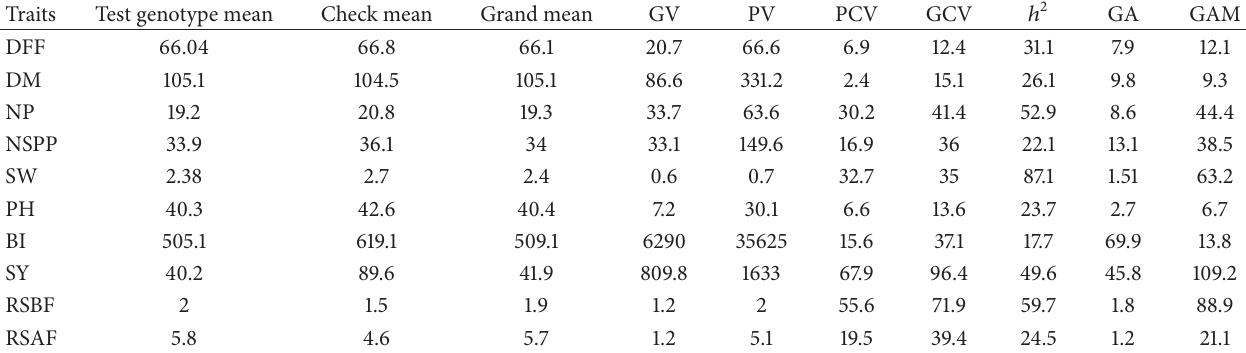
Traits Test genotype